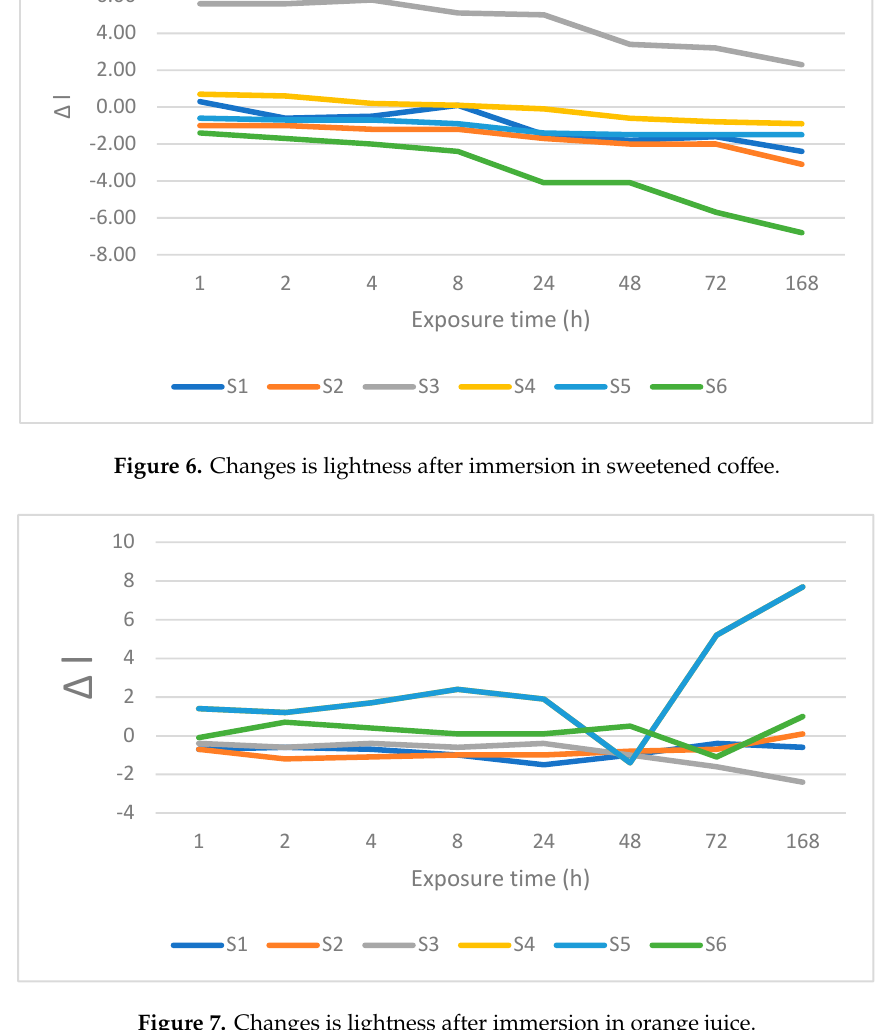
Figure 7. Changes is lightness after immersion in orange juice.